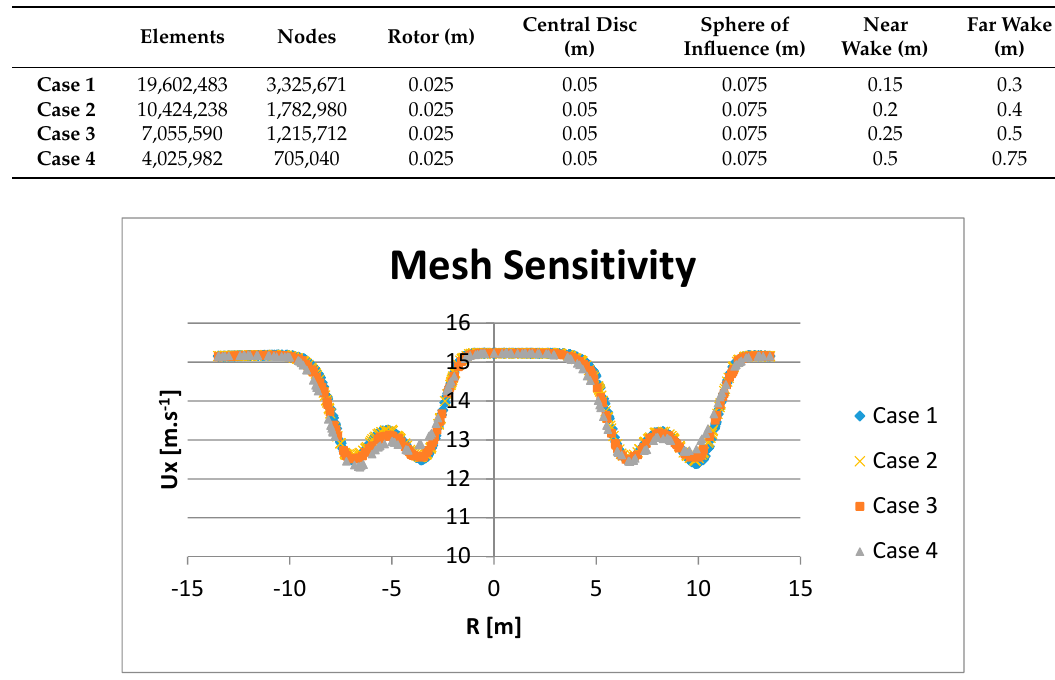
Figure A2. Mesh sensitivity study.